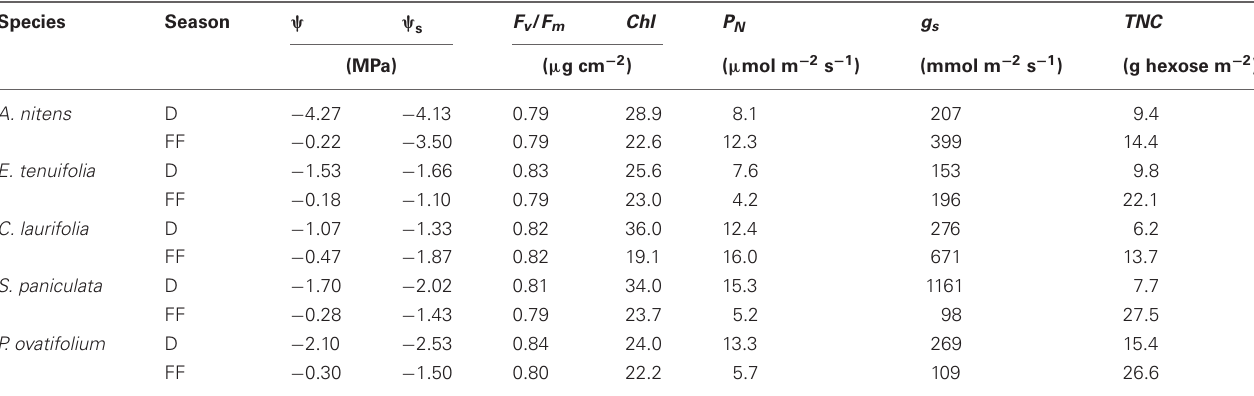
Table 1 | Changes from drainage (D) to full-flooding (FF) in morning leaf water ( ψ ) and osmotic ( ψ s ) potential, maximum quantum yield of PSII (F v /F m ), total chlorophyll content (Chl), photosynthetic rate (P N ), stomatal conductance (g s ), and total non-structural carbohydrate contents (TNC) as hexose equivalents of the species